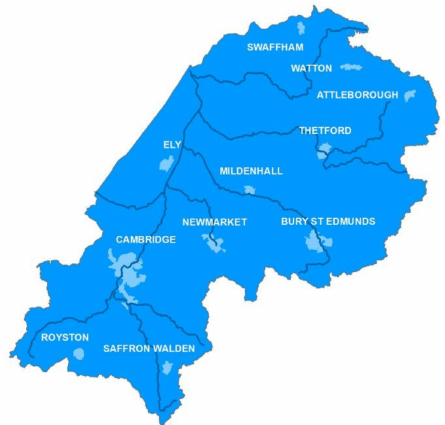
Figure 1. CamEO catchment area showing the main rivers and tributaries